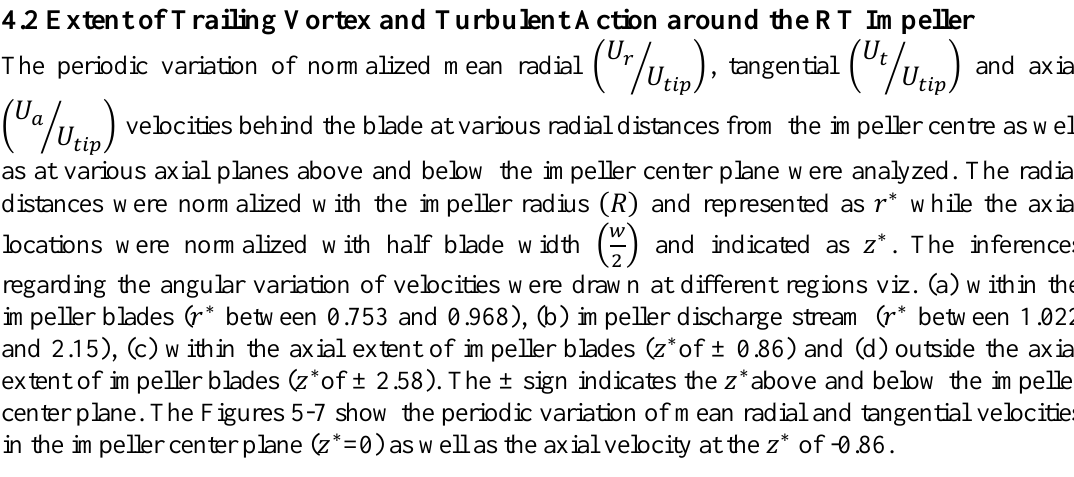
Figure 5. Periodic variation of